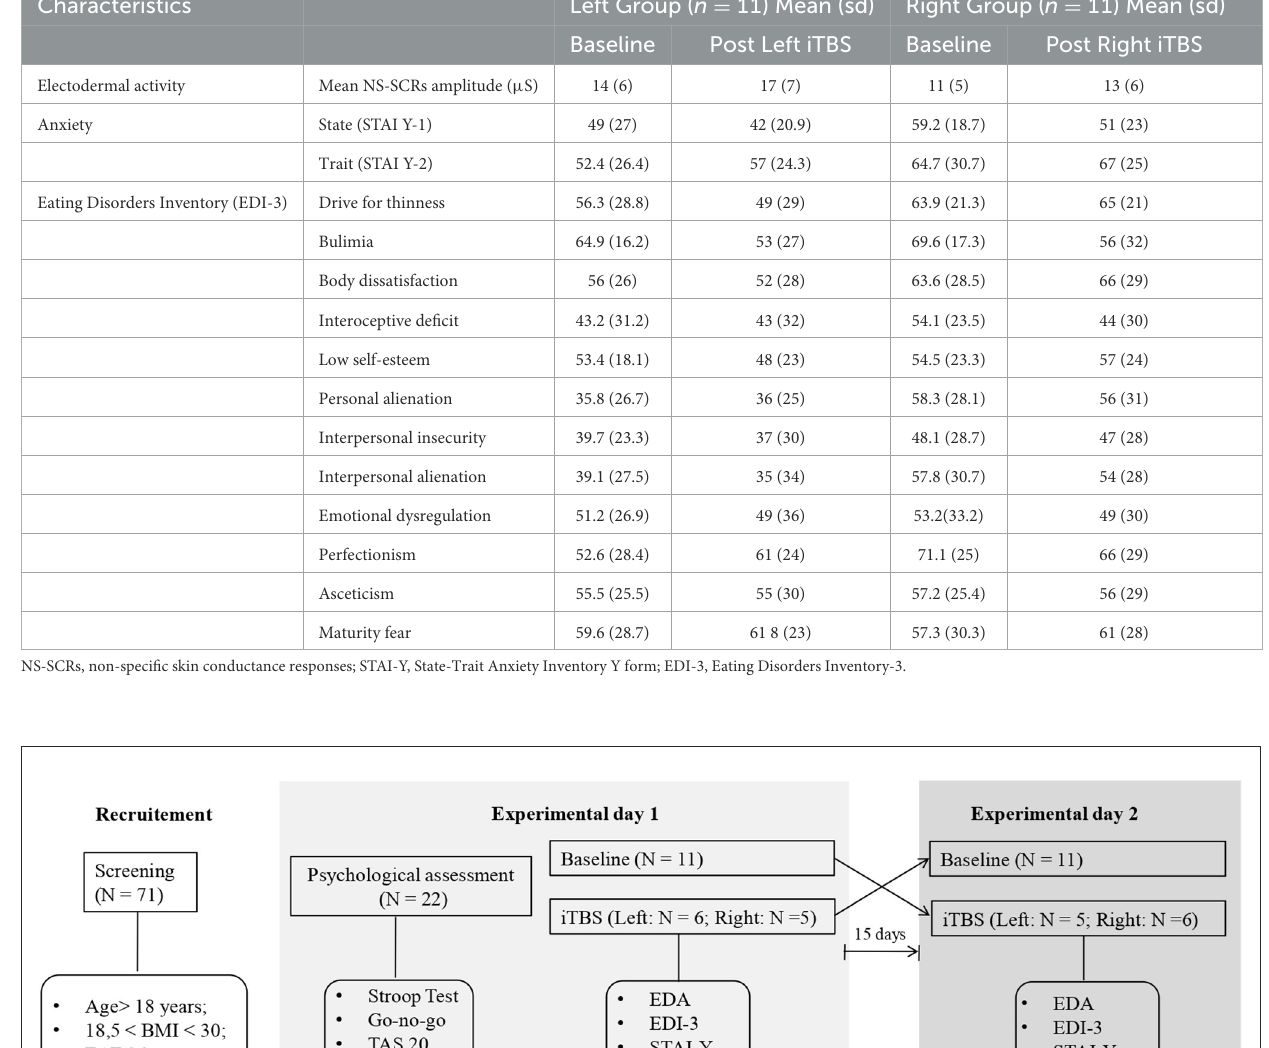
TABLE 2 Descriptive statistics of each administered test for the two groups of participants before and after the DLPFC iTBS. Characteristics